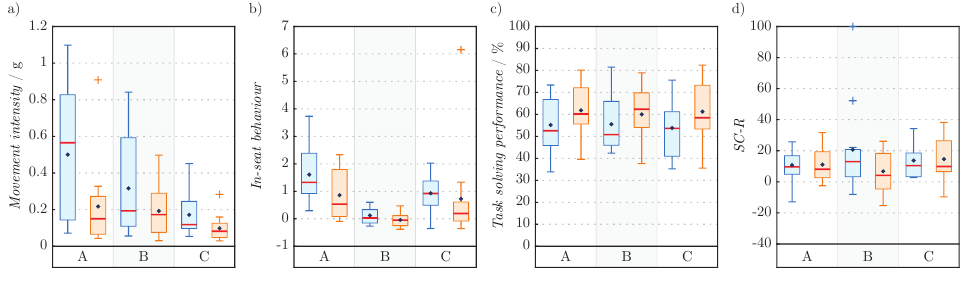
Figure 5. ( a ) Intensity of movement, ( b ) in-seat behaviour, ( c ) cognitive tests solving performance, ( d )